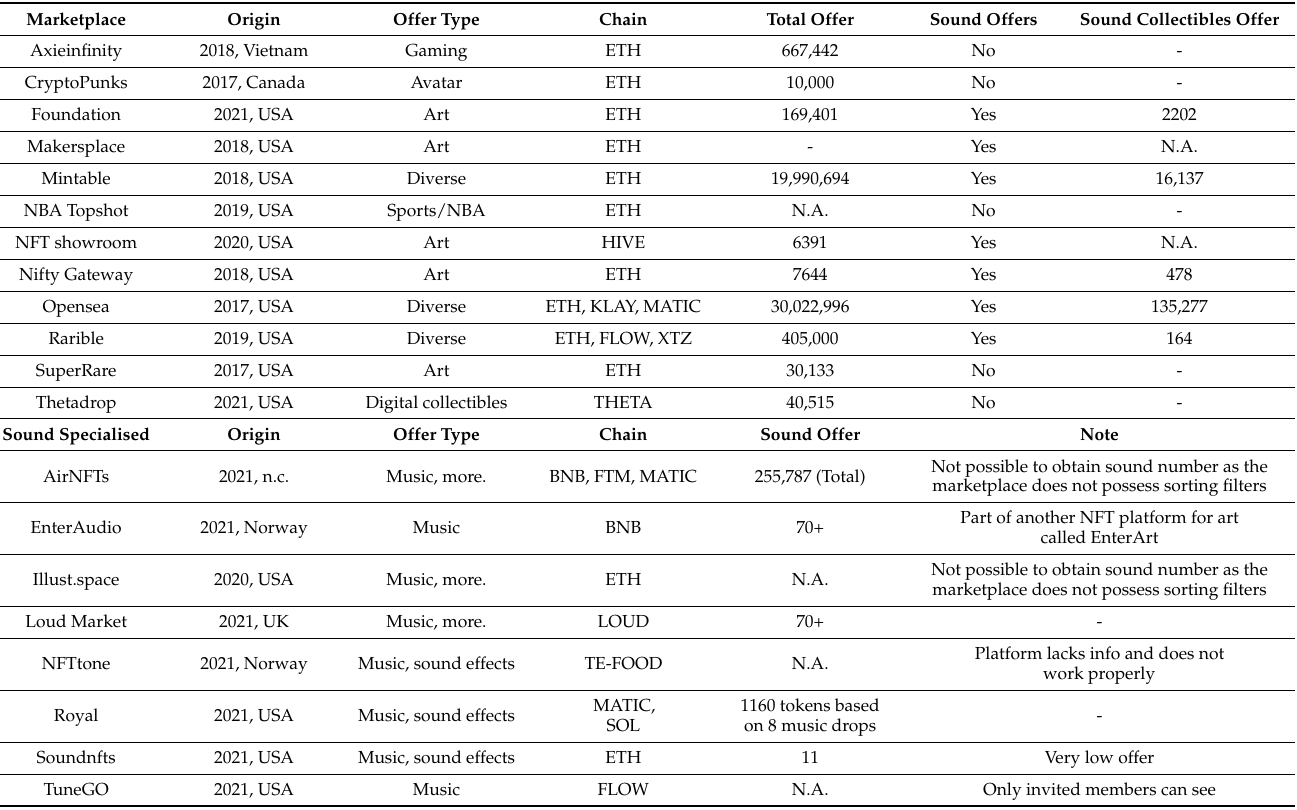
Table 3. NFT marketplaces under